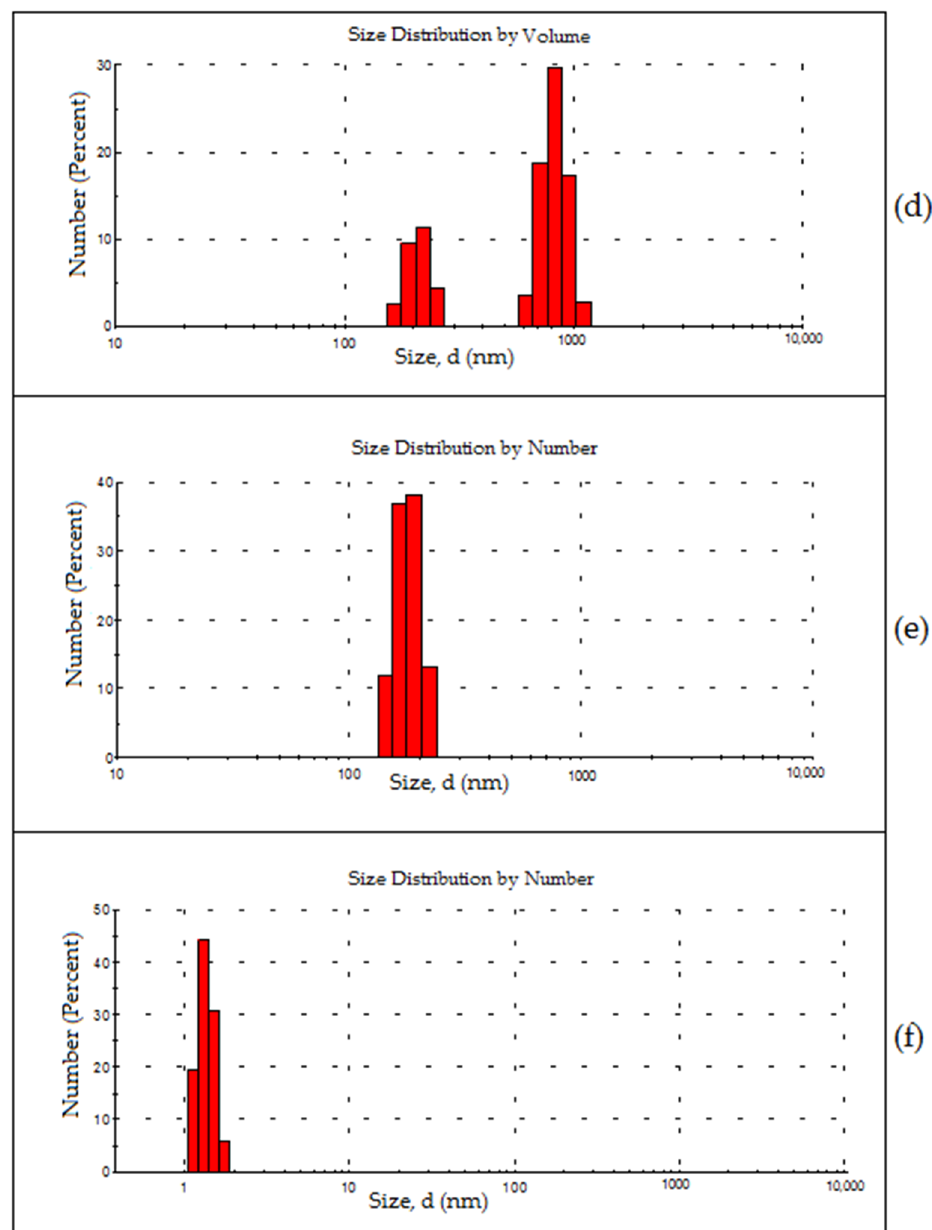
Figure 9. Aggregates size distribution obtained from DLS for various concentrations of the IL 4-PyC8 in drug PMZ and gemini surfactant 16-10-16: ( a ) 16-10-16 (without additives), ( b ) 16-10-16:PMZ, ( c , d ) 16-10-16:PMZ:0.1 wt% IL 4-PyC8, ( e ) 16-10-16:PMZ:0.5 wt% IL 4-PyC8 and ( f ) 16-10-16:PMZ:1.0 wt% IL 4-PyC8.